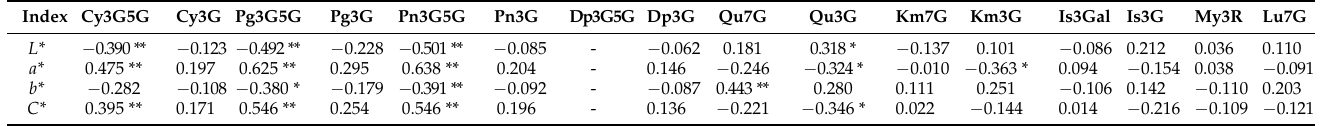
Table 5. Correlation analysis of pigment content and L * a * b * values in petals.